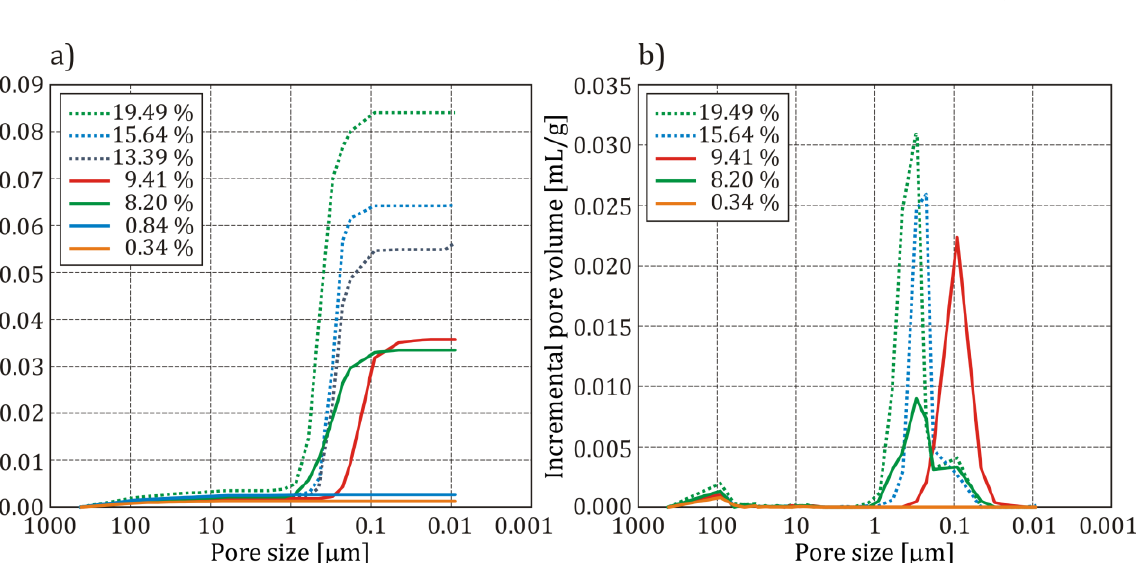
Figure 2. Cumulative pore volume ( a ) and incremental pore volume ( b ) vs. pore size curves for samples of different porosity and pore distribution, G-5 borehole.